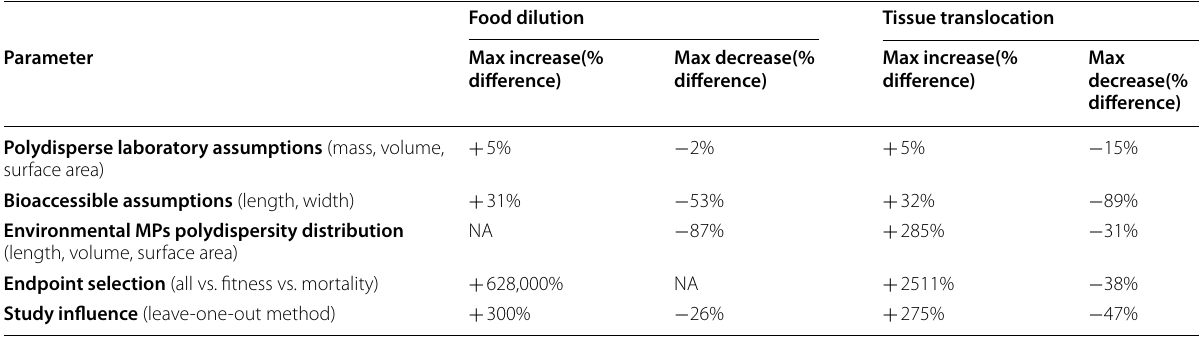
Table 4 Sensitivity analyses to assess the impact of alignment method, endpoint selection and individual studies, on the threshold values calculated Food